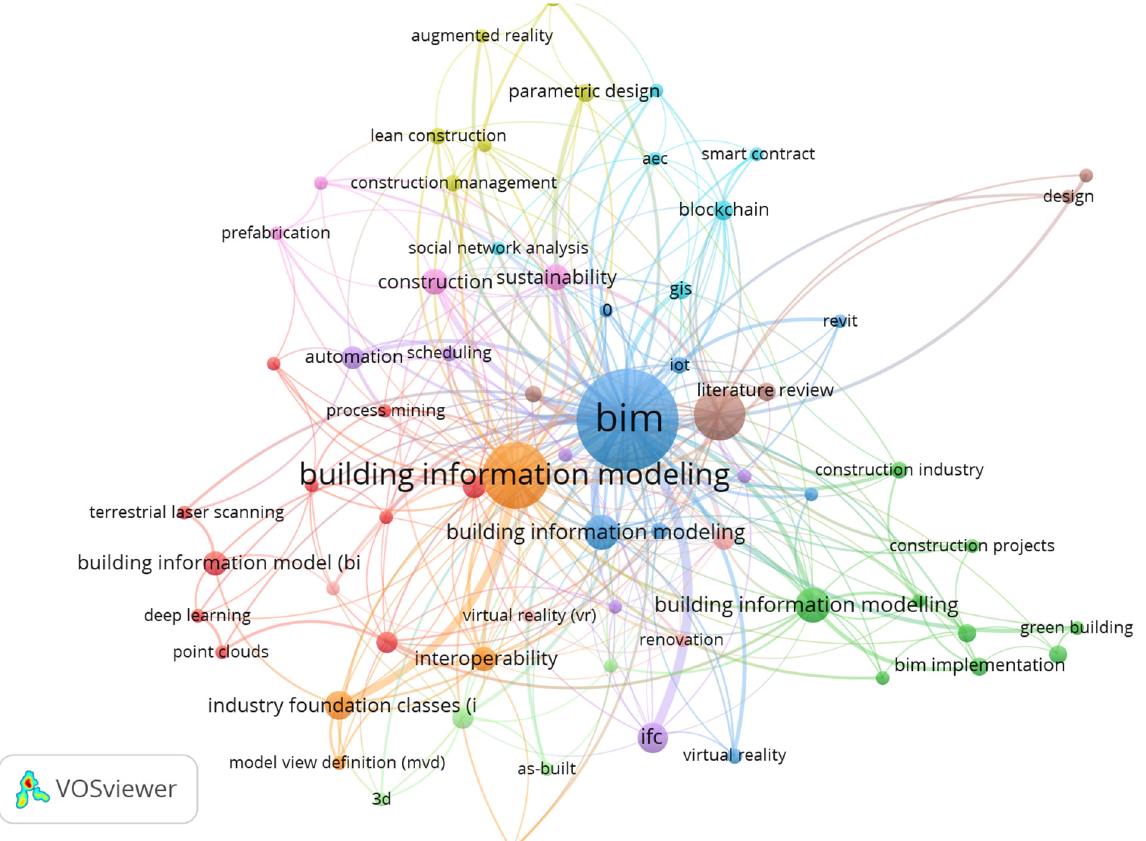
Figure 11. Network visualization map of most related topics in BIM.